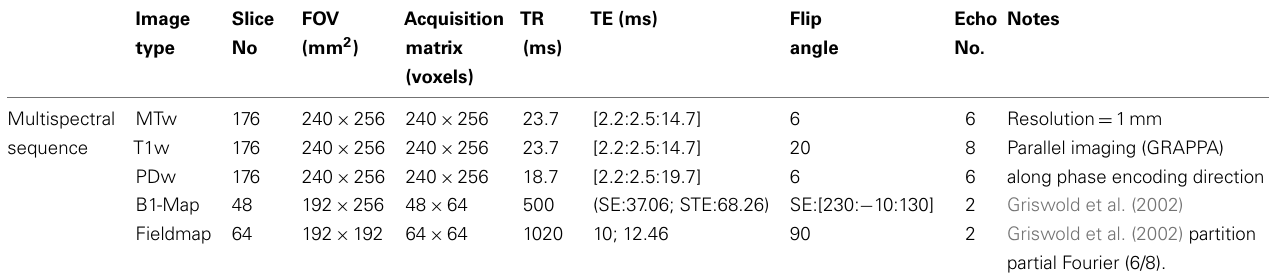
Table 1 | Imaging parameters.